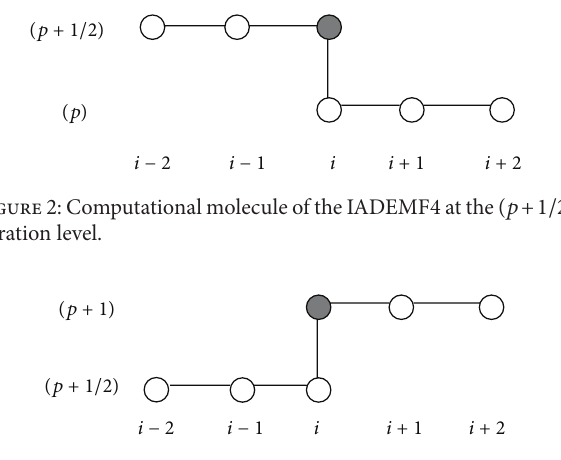
Figure 3: Computational molecule of the IADEMF4 at the (𝑝 + 1) iteration